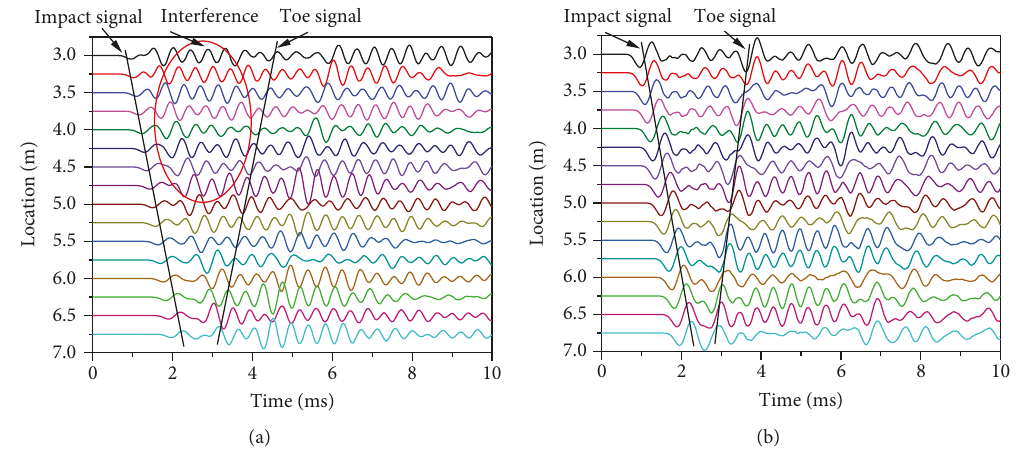
Figure 18: Raw velocity data. (a) Velocity data at A